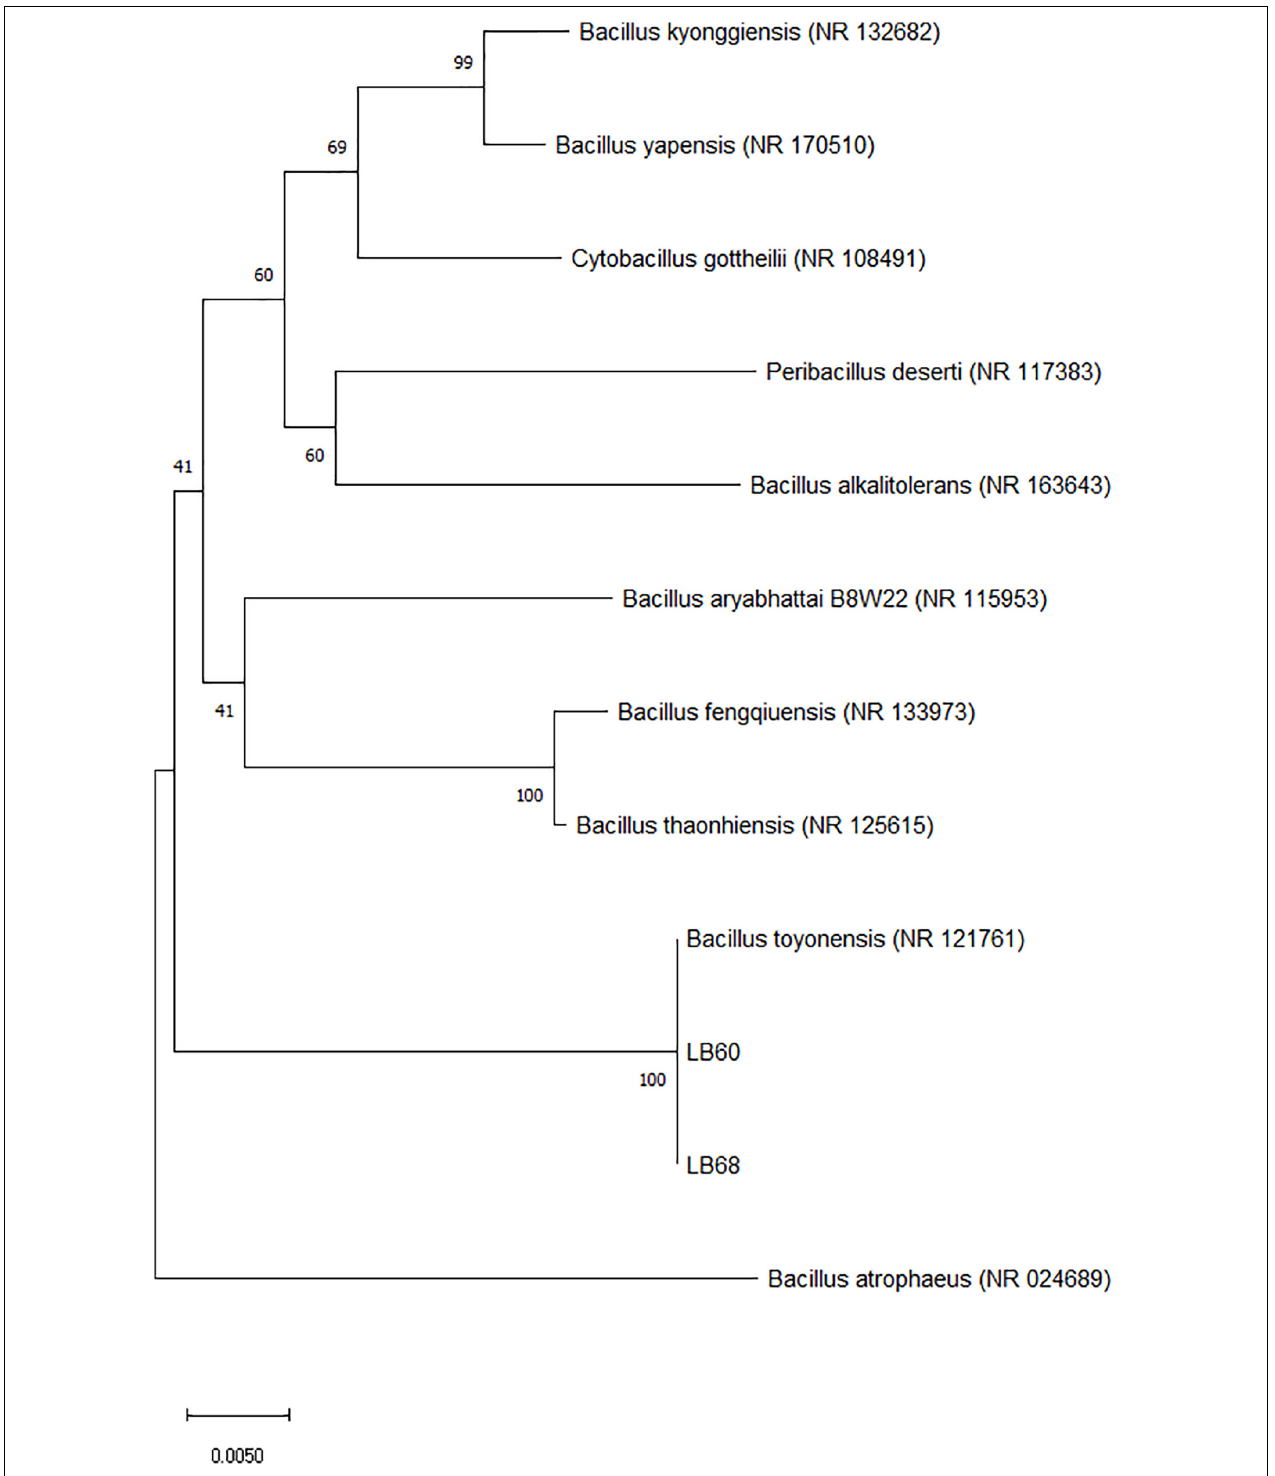
FIGURE 1 | Phylogenetic analysis of the isolates (filled rectangle) based on the 16S rRNA gene sequences. Accession numbers for the available 16S rRNA gene sequences used are given in parentheses behind species and strain names. The phylogenetic tree was calculated and drawn by using the MEGA version X software after multiple alignments of the data by CLUSTAL W. The tree was constructed using the neighbor-joining method, and the evolutionary distances were computed using the p-distance method. The numbers at the branches are bootstrap confidence percentages (%) based on 1000 resampled data sets. Bar, 0.0050 substitutions per nucleotide